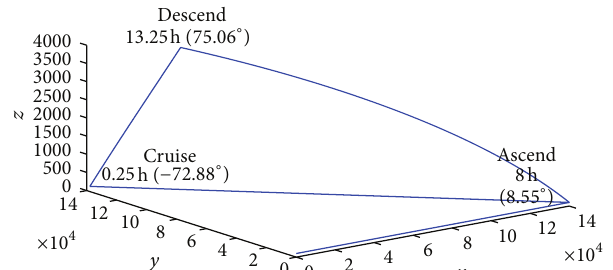
Table 3: Comparison of the proposed model with different